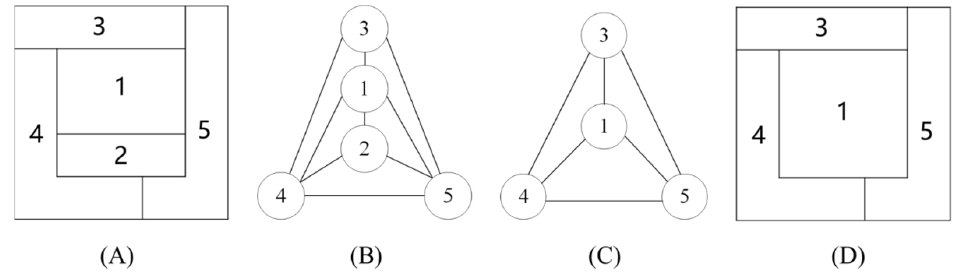
Figure 6. Example of the region-merging process: ( A ) initial segmentation result; ( B ) RAG of ( A ); ( C ) RAG after region merging; ( D ) region-merging result.